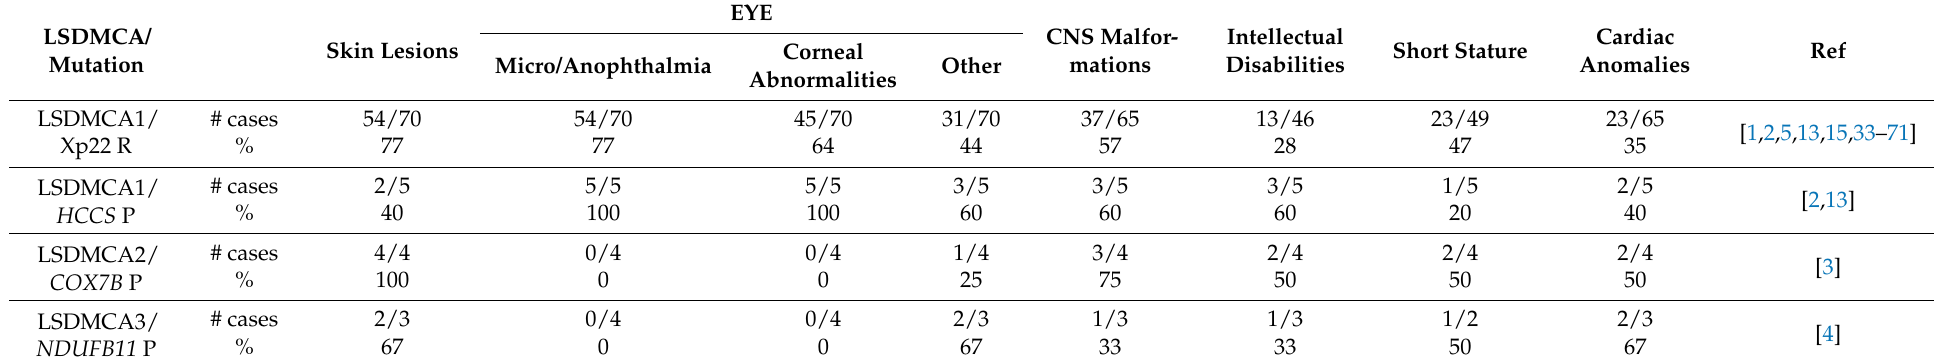
Table 2. Summary of clinical findings found in LSDMCA. Extended details can be found in Table S1.